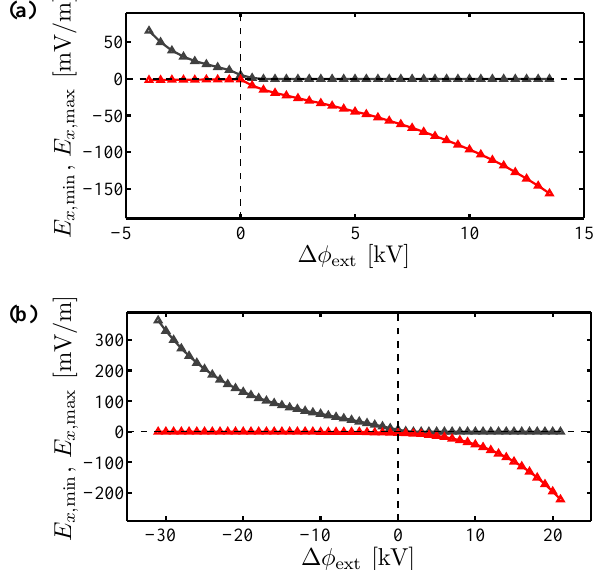
Fig. 5. Maximum (black) and minimum (red) electric field values in (a) a cold–hot tangential discontinuity and (b) a hot–hot disconti- nuity (see caption of Fig. 3) as a function of external electric poten- tial difference. Both plots indicate the existence of upper and lower Fig. 6. Existence of a tangential discontinuity equilibrium be- limits to the external potential difference for which an equilibrium tween (a) cold and hot plasmas, with the cold plasma density being can be found. Only for small | 1φ ext | less than a few kV one finds 0 . 1cm − 3 and the hot plasma density varying between 0 . 001cm − 3 | E x,max | ≈ | E | ; the interfaces are characterized by a monopo- x,min and 1cm − 3 , and (b) two hot plasmas, with a density on the left lar electric field signature elsewhere. side of 0 . 1cm − 3 and a density on the right side varying from 0 . 001cm − 3 to 1cm − 3 . In both cases the computations have been carried out over a broad range of EEPD values. The red regions in- dicate the existence of a tangential discontinuity; in the blue regions no tangential discontinuity equilibrium is